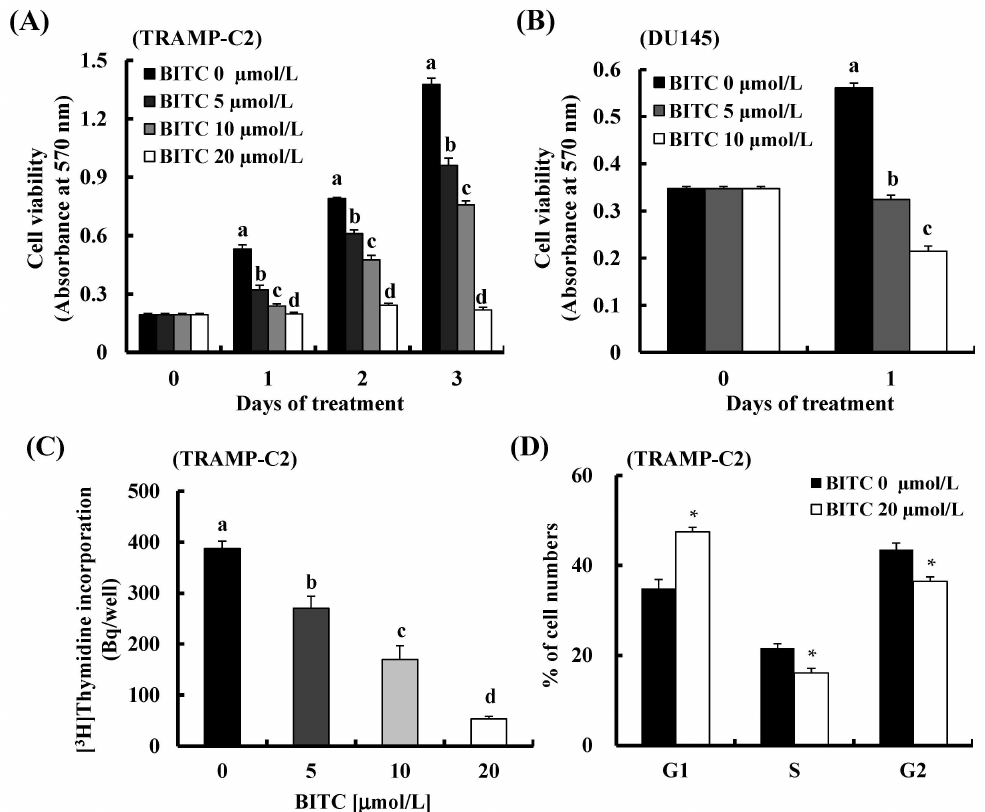
Figure 3. BITC inhibits cell proliferation and induces G1 cell cycle arrest in TRAMP-C2 cells. TRAMP-C2 or DU145 cells were plated in 24-well plates at 5 ˆ 10 4 cells/well. Twenty-four hours after plating, the monolayers were serum-deprived in DMEM/F12 containing 1% charcoal-stripped FBS for 6 h. ( A ) TRAMP-C2 cells were treated with 0, 5, 10, or 20 µ mol/L BITC for one, two, and three days; ( B ) DU145 human prostate cancer cells were treated with 0, 5, or 10 µ mol/L BITC for one day. ( A , B ) Viable cell numbers were estimated by MTT assay. Each bar represents the mean ˘ SEM ( n = 6); ( C ) TRAMP-C2 cells were treated with 0, 5, 10, or 20 µ mol/L BITC in the presence of [ 3 H]thymidine for 3 h. Each bar represents the mean ˘ SEM ( n = 6); ( D ) TRAMP-C2 cells were incubated for 3 h in serum-deprivation medium containing BITC (0 or 20 µ mol/L). The nuclei were stained with propidium iodide and the cell cycle was analyzed via flow cytometry. Each bar represents the mean ˘ SEM ( n = 5). ( A – C ) Means without a common letter differ, p < 0.05; ( D ) * p < 0.05 as compared with the control